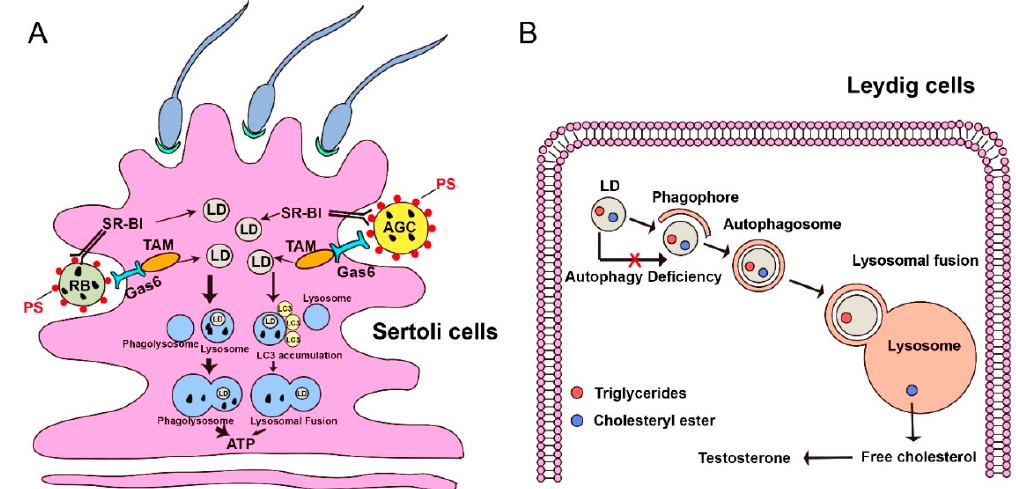
Figure 3. Lipophagy promotes spermatogenesis in Sertoli cells and regulates the synthesis of testosterone in Leydig cells. ( A ) During spermatogenesis, apoptotic germ cells (AGCs) and residual bodies (RBs) are phagocytosed by Sertoli cells by the SR-BI/PS (Class B scavenger receptor type I / Phosphatide) system or TAM/Gas 6 (Translocation and assembly module/Growth arrest-specific 6) system. The lipid droplets can release from the breakdown of engulfed AGCs and RBs. In this condition, most LDs fused with the lysosome to form phagolysosome to generate energy for Sertoli cells, which further supports germ cell and spermatogenesis. While, minor LDs can have an LC3 accumulation signal and then fuse with the lysosome to produce ATP for energy support. PS, a type of phospholipid. LD, lipid droplet. Bigger arrow, a major pathway to degrade LDs in Sertoli cells. Smaller arrow, a minor pathway to degrade LDs in Sertoli cells. ( B ) LDs are composed of cholesteryl ester and triglycerides, which are localized in the Leydig cells. In normal conditions, lipophagy can degrade cholesterol esters into free cholesterol, an essential substrate for testosterone synthesis. When autophagy deficient, the substrate of testosterone will decrease due to the failure of lipophagy.